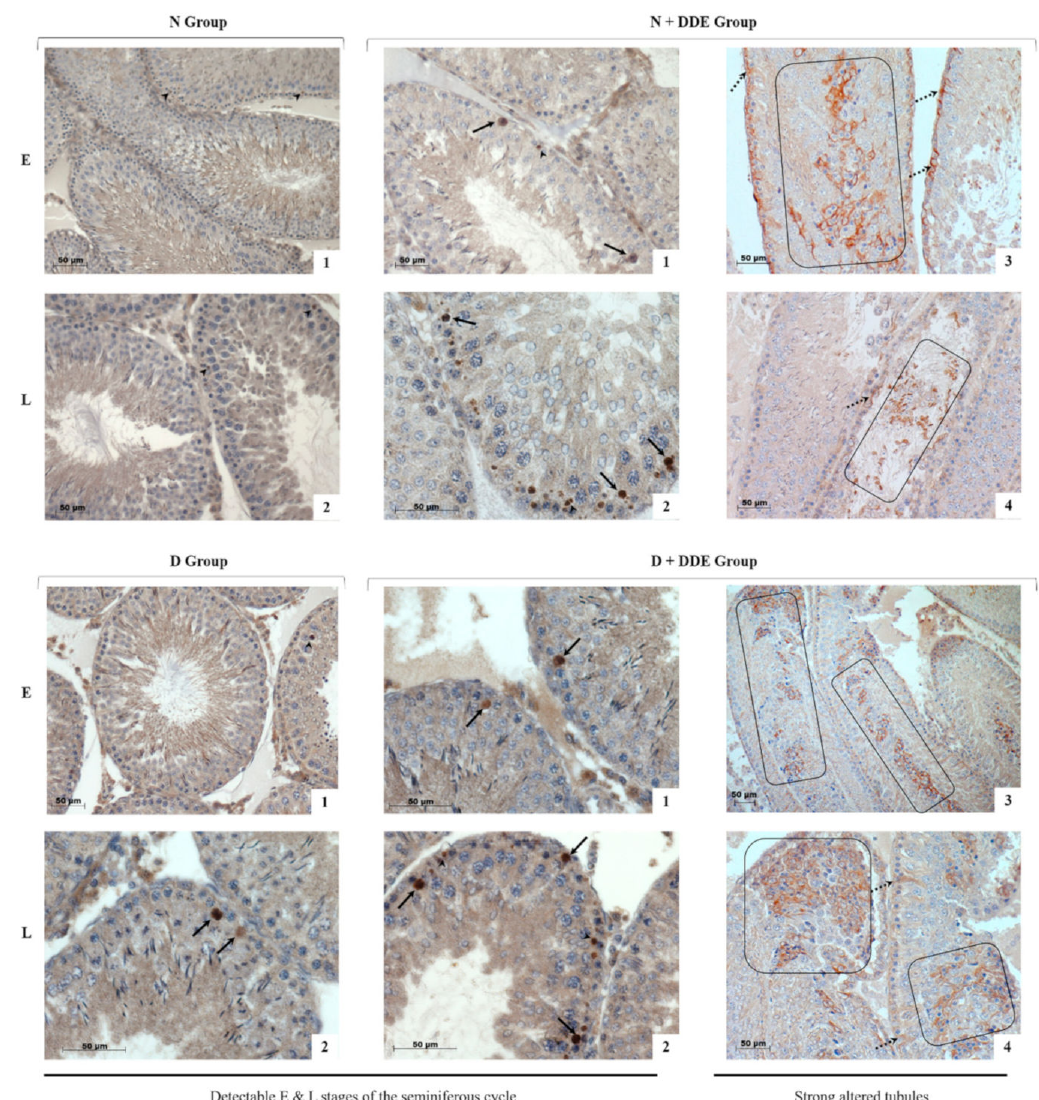
Figure 4. Immunohistochemical stain for cl-Casp3 was faint in the control rats (N group), only some apoptotic residual body were positive (arrowheads, panels 1–2). In D group, an increased number of residual bodies were observed (arrowhead, panel 1), as well as some spermatogonia at basement membrane (black arrows, panel 2). In DDE-treated groups, a larger amount of residual bodies was found in both N + DDE (arrowheads, panel 1) and D + DDE groups (arrowheads, panel 2). In addition, a lot of basal cells in some tubules (spermatogonia and spermatocytes, black arrows) were found positive to cl-Casp3 antibody (N + DDE, panels 1–2); (D + DDE, panels 1–2). The cells depleted in the lumen of the tubules were heavily marked (N + DDE, black rectangle, panels 3–4); (D + DDE, black rectangles, panels 3–4). Moreover, Sertoli cells positive to cl-Cas3 were found in both N + DDE (dashed arrows, panels 3–4) and D + DDE (dashed arrows, panel 4)